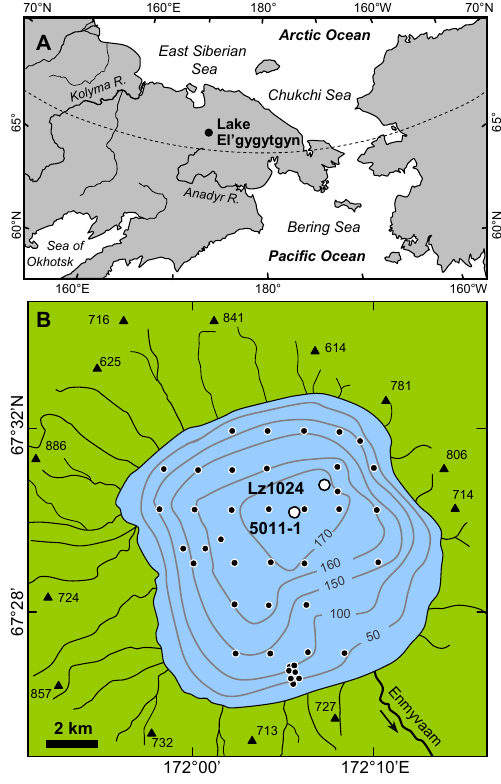
Fig. 1. Maps showing (A) geographical location of Lake El’gygytgyn (black dot; 67 ◦ 30 0 N, 172 ◦ 05 0 E; 492ma.s.l.) in north- eastern Siberia; and (B) the catchment area of Lake El’gygytgyn with associated hydrological network. The lower map (B) also shows the locations of the modern pollen surface samples (closed circles) and fossil pollen records (open circles), bathymetric lines indicating lake water depth (m below modern lake level), and high- est mountain peaks (triangles accompanied with altitude values in